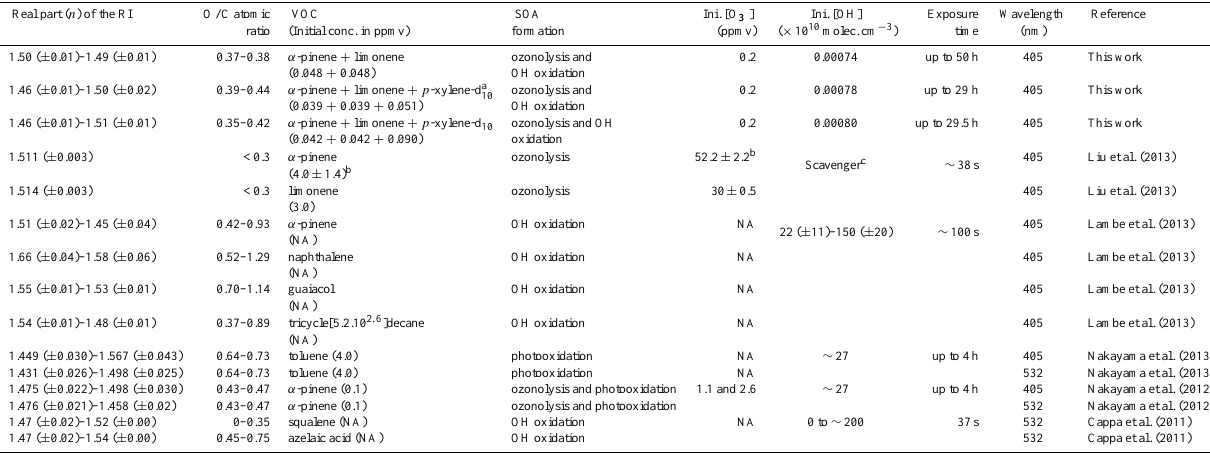
Table 2. Real parts of the RI for different O/C ratios in this study compared with literature values. Realpart( n